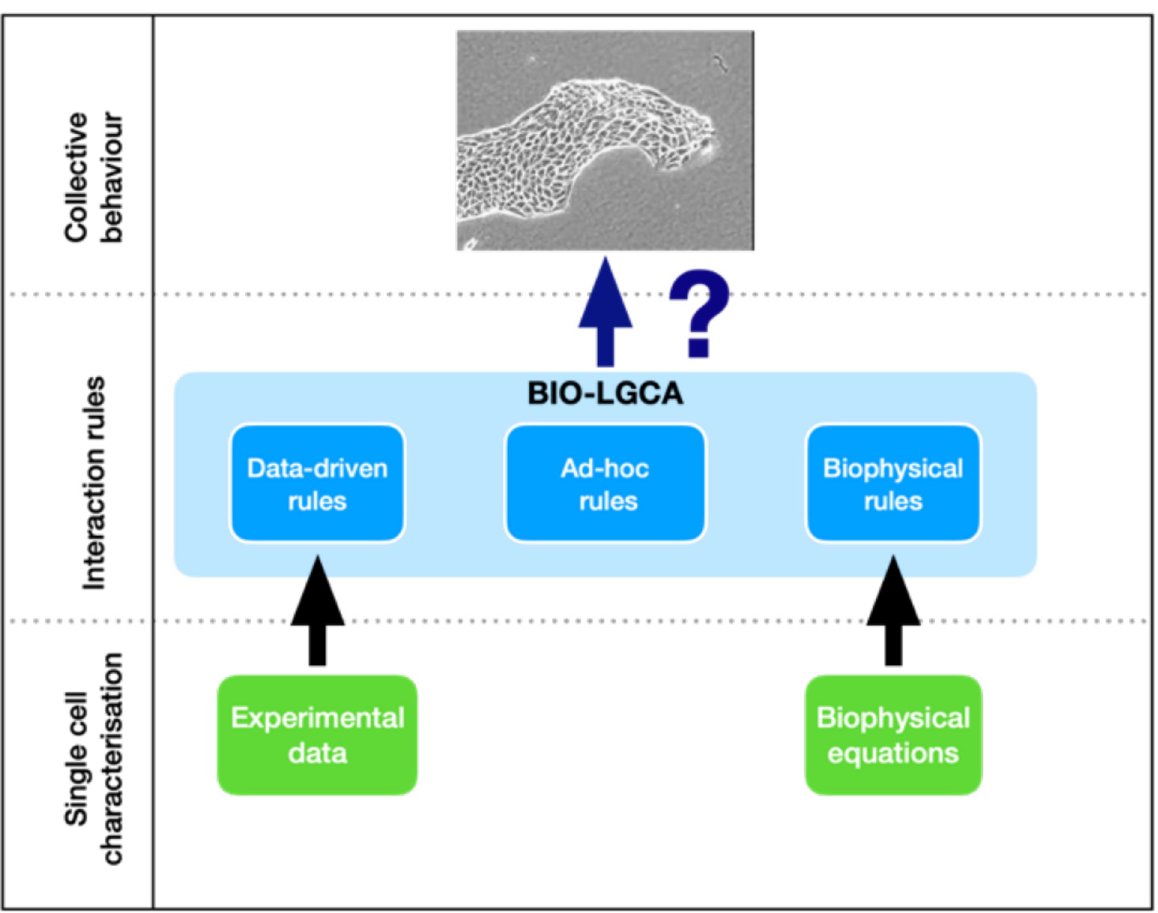
Fig 1. BIO-LGCA modelling. The key question is to identify the interaction rules underlying a particular collective phenomenon in a population of cells. BIO-LGCA interaction rules can be chosen ad hoc, extracted from experimental single cell migration data, or derived from biophysical equations for single cell